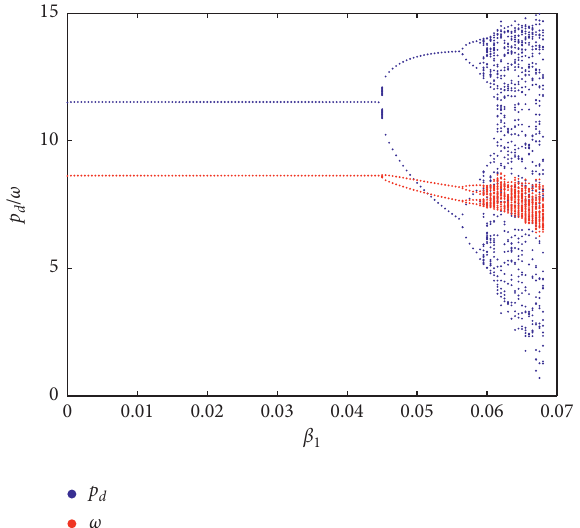
Figure 6: Bifurcation diagram of p